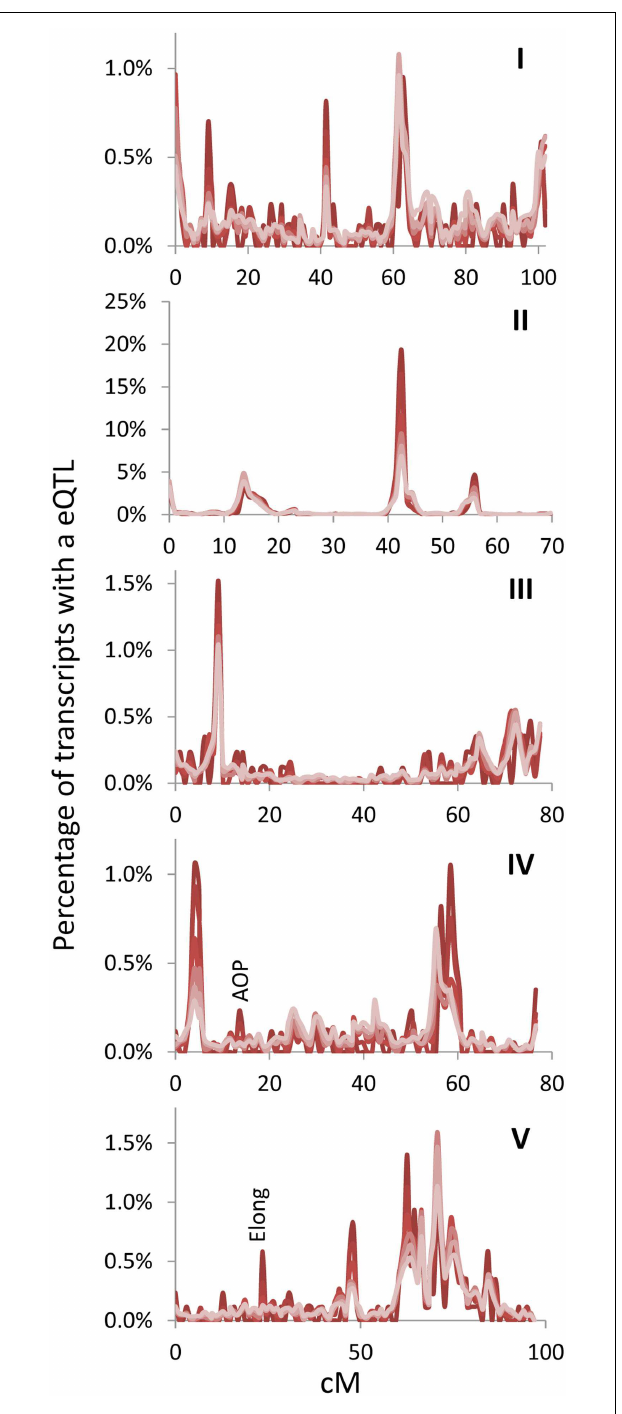
FIGURE 3 | Hotspot identification with different size gene sets. eQTL hotspot identification across the five Arabidopsis chromosomes are shown with the darkest red being for the top 500 expressed genes and progressively lighter shades of red representing 1000, 2500, 5000, 10,000, and the lightest red being all 22,746 transcripts in the experiment. eQTLs per every cM are plotted without smoothing. AOP and Elong show the position of known pathway specific trans eQTL hotspots for the glucosinolate pathway. Chromosomes are shown in Latin